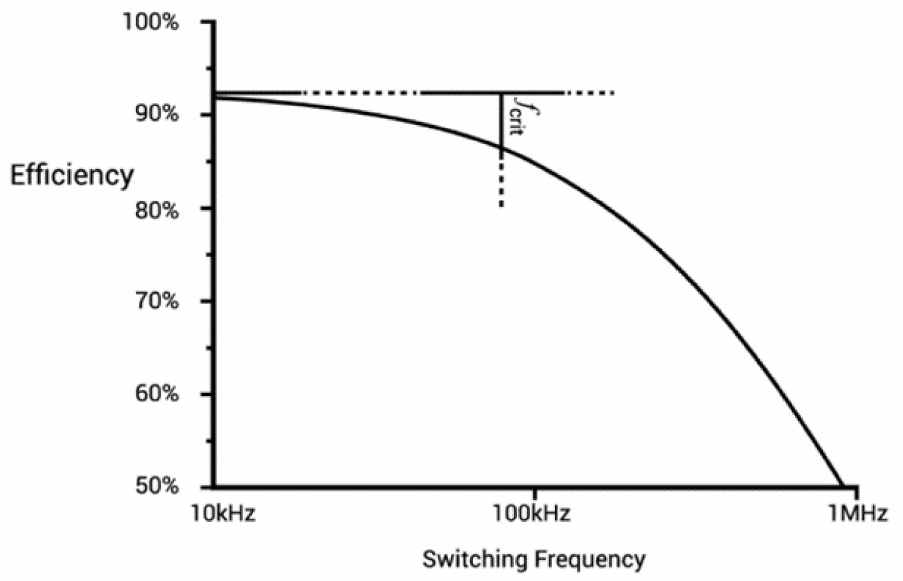
Figure 3. Efficiency vs. switching frequency variation in switching